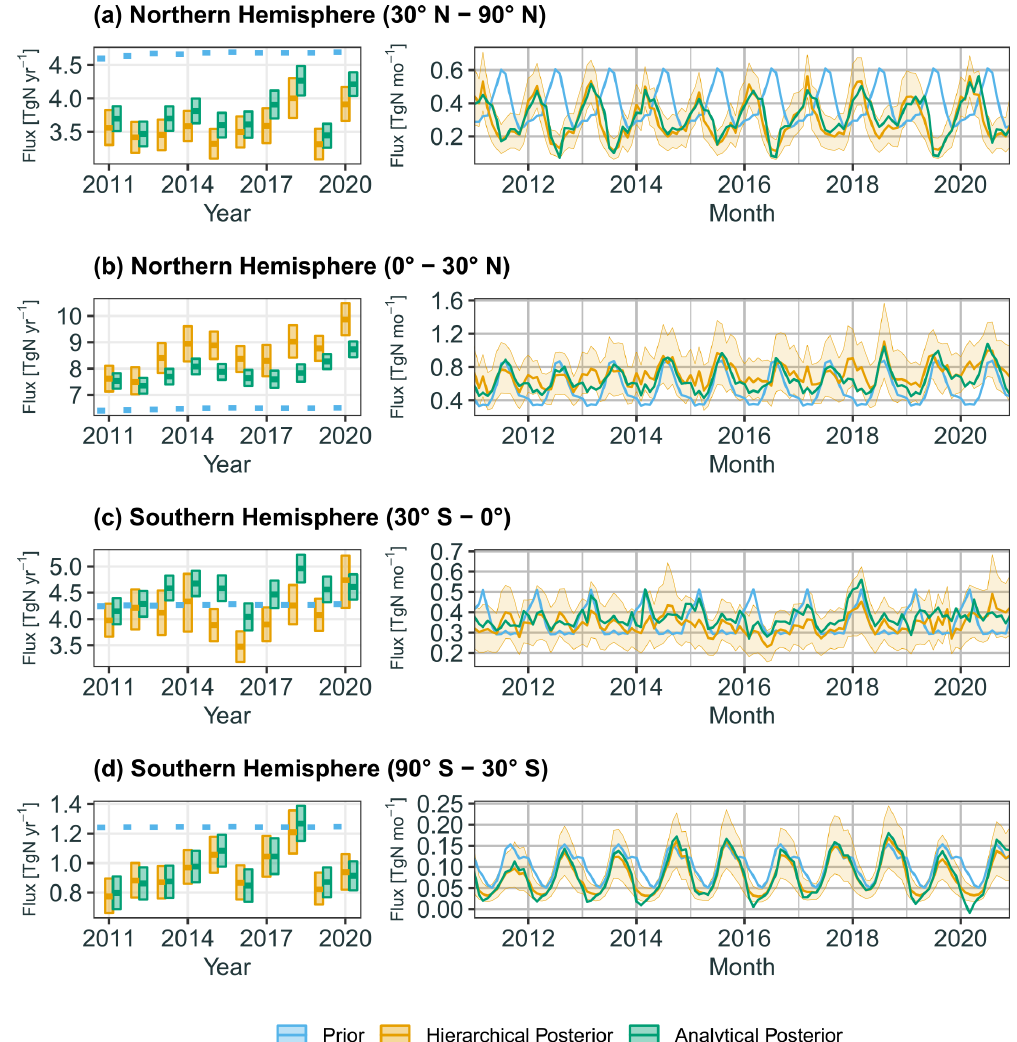
Figure 7. Inferred nitrous oxide emissions for 2011–2020 in four zonal bands: (a) Northern Hemisphere (30–90 ◦ N), (b) Northern Hemi- sphere (0–30 ◦ N), (c) Southern Hemisphere (30 ◦ S–0 ◦ ), and (d) Southern Hemisphere (30–90 ◦ S). Plots on the left-hand side show annually averaged emissions and on the right-hand side show monthly emissions, where orange is the hierarchical inversion posterior, green is the an- alytical inversion posterior, and blue is the prior, with the shading showing the 95% credible intervals of the hierarchical inversion